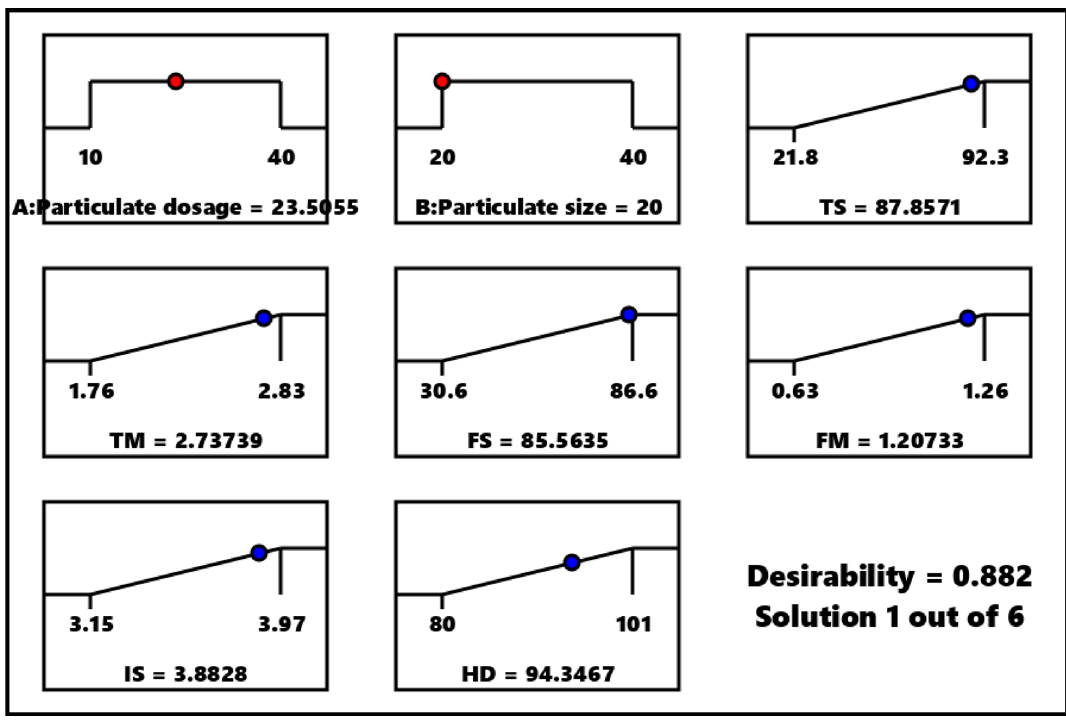
Figure 7. Optimization ramp for